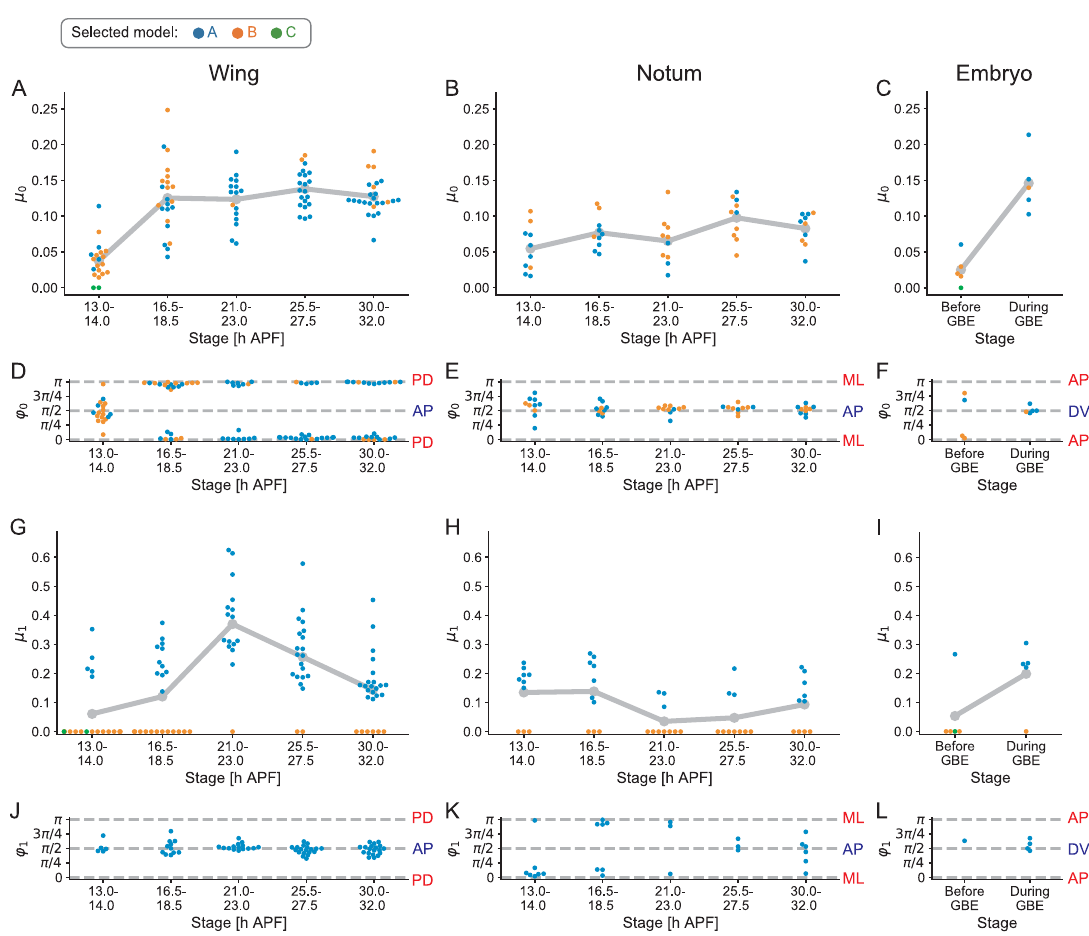
Fig 6. Developmental changes in tension anisotropy parameters in Drosophila epithelial tissues. (A–L) Developmental changes in the estimated values of μ 0 (A–C; the anisotropy in the line tension), φ 0 (D–F; the orientation of anisotropy in the line tension), μ 1 (G–I; the anisotropy in the spring constant of junction), and φ 1 (J–L; the orientation of anisotropy in the spring constant of junction). Each dot shows the estimated value of a parameter in each sample at the stage indicated in the pupal wing (A, D, G, J), pupal notum (B, E, H, K), and embryo (C, F, I, L). The gray line connects the average values of μ 0 and μ 1 for each stage. Dot colors represent a model selected by